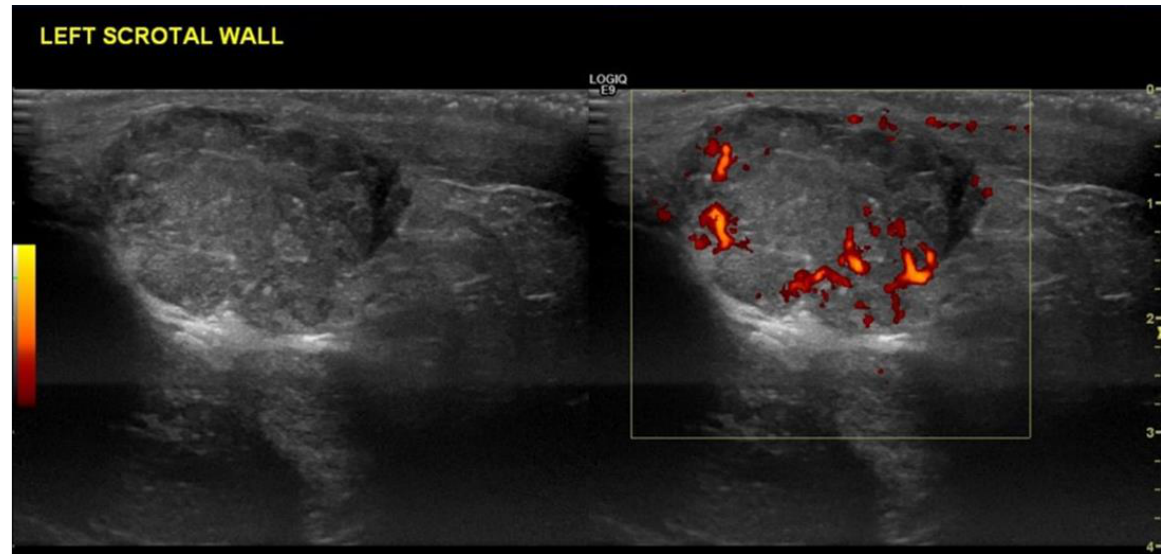
Figure 9. B-mode and power Doppler ultrasound in a patient with previous testicular malignancy demonstrates local recurrence in the scrotum. This patient presented following trauma and had undergone a scrotal incision rather than the conventional inguinal